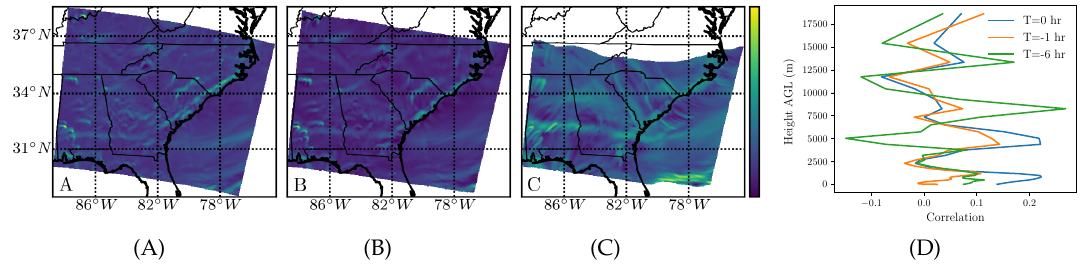
Figure 9. The same as in Figure 4, but for sodium (Na + ).